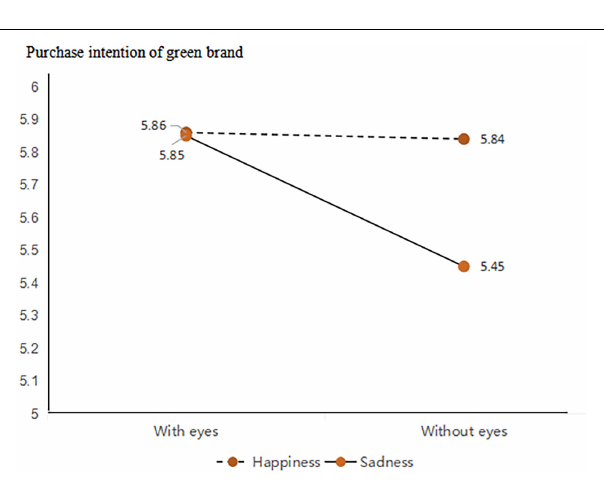
FIGURE 15 | Moderating role of